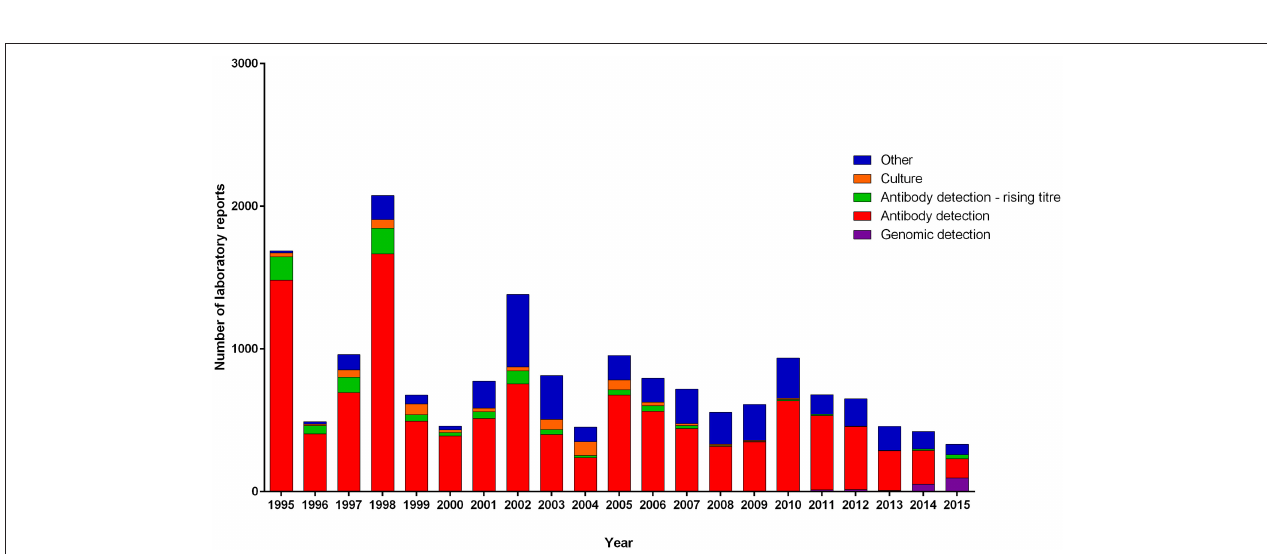
FIGURE 2 | Number of laboratory reports per year from January 1995 to June 2015 separated by detection methodology. National reporting categories included are: antibody detection and antibody-detection rising titre. A rising titre is defined as a four-fold increase in detectable anti- Mycoplasma pneumoniae antibody level (methods not specified). Other indicates specimens for which M. pneumoniae infection was determined using antigen detection (method not specified), microscopy and unknown categories. Culture indicates cases from which specimens yielded isolates of M. pneumoniae and genomic detection those for which DNA of M. pneumoniae was detected by